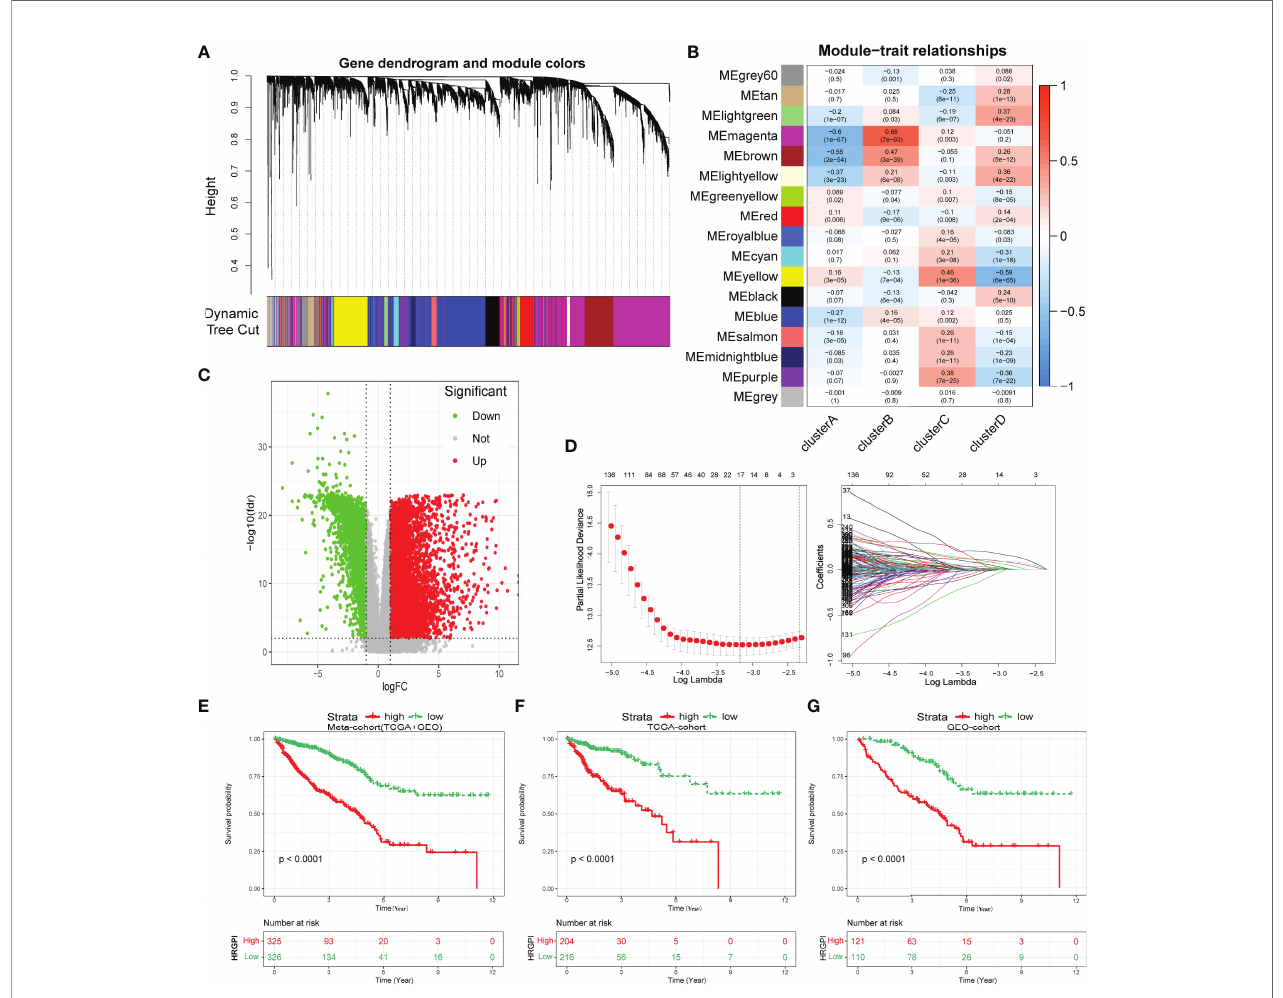
FIGURE 4 | Construction of hypoxia-related gene signature index (HRGPI). (A) Identi fi cation of 17 modules by setting the merging threshold function at 0.25. (B) Correlation coef fi cient between a module and sample feature for each module. (C) Volcano plot about DEGs between tumor and normal samples. (D) Determination of the number of factors by the LASSO analysis. (E – G) Kaplan – Meier plots of OS for patients in the HRGPI-high and HRGPI-low